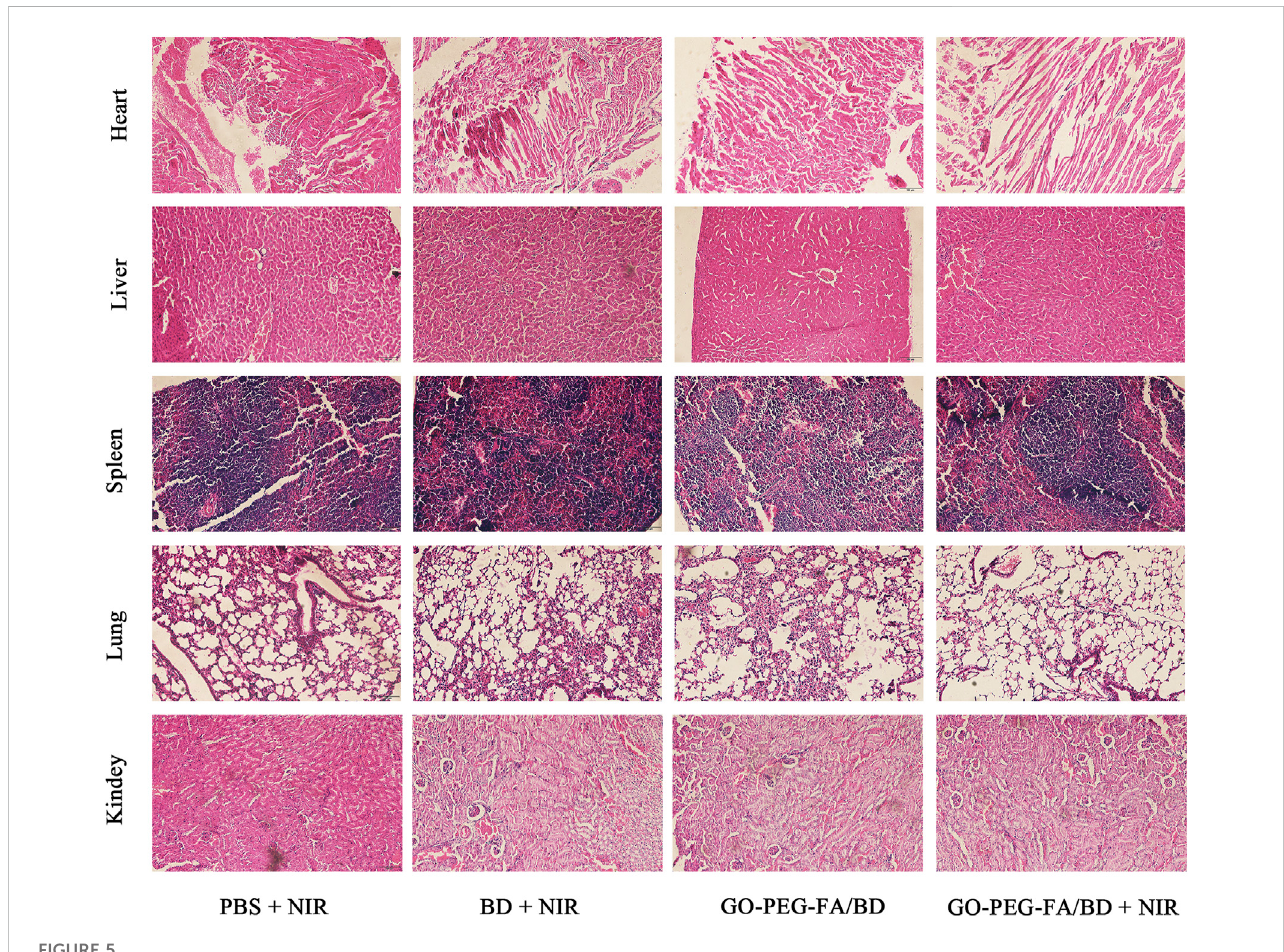
FIGURE 5 HE staining of major organs of the tumor-bearing mice after various